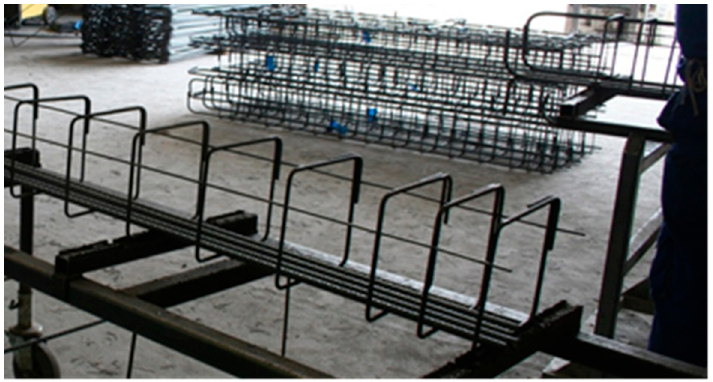
Figure 1. Rebar Figure 1. Rebar production.